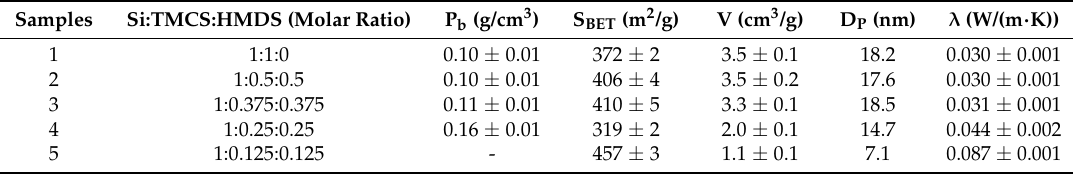
Figure 4. N 2 adsorption–desorption isotherms ( a ) and pore size distributions ( b ) of silica aerogels with different f silylation agents. Table 3. Textural parameters and thermal conductivities of silica aerogels with different silylation agents.